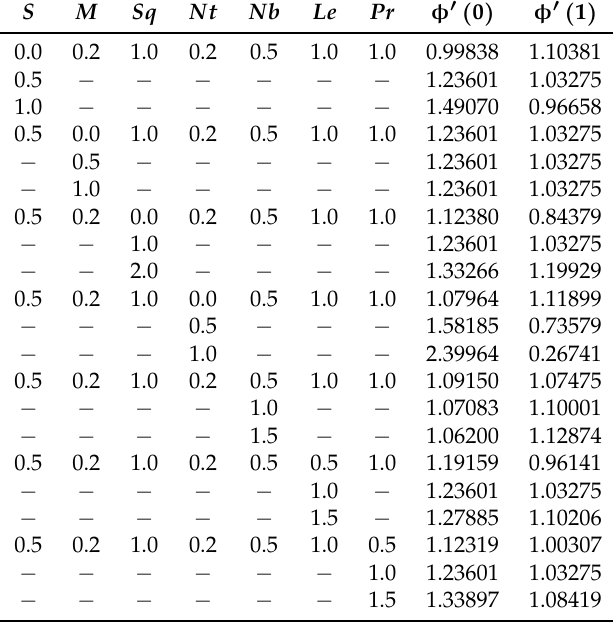
Table 6. Numerical data for local Sherwood number at the lower and upper disks for several values of S , M , Sq , Nt , Nb , Le and Pr